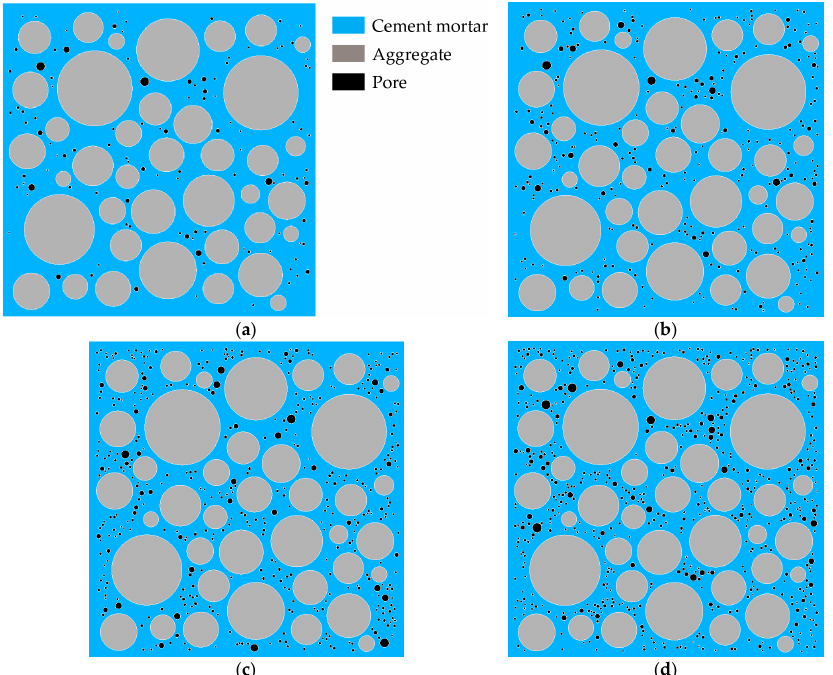
Figure 2. Some specimens with the same aggregate structure and total porosity but different pore structure as the specimens shown in Figure 1. ( a ) 1-2-X (total porosity = 1%); ( b ) 2-2-X (total porosity = 2%); ( c ) 3-2-X (total porosity = 3%); ( d ) 4-2-X (total porosity = 4%). ( c ) 3-2-X (total porosity = 3%); ( d ) 4-2-X (total porosity =